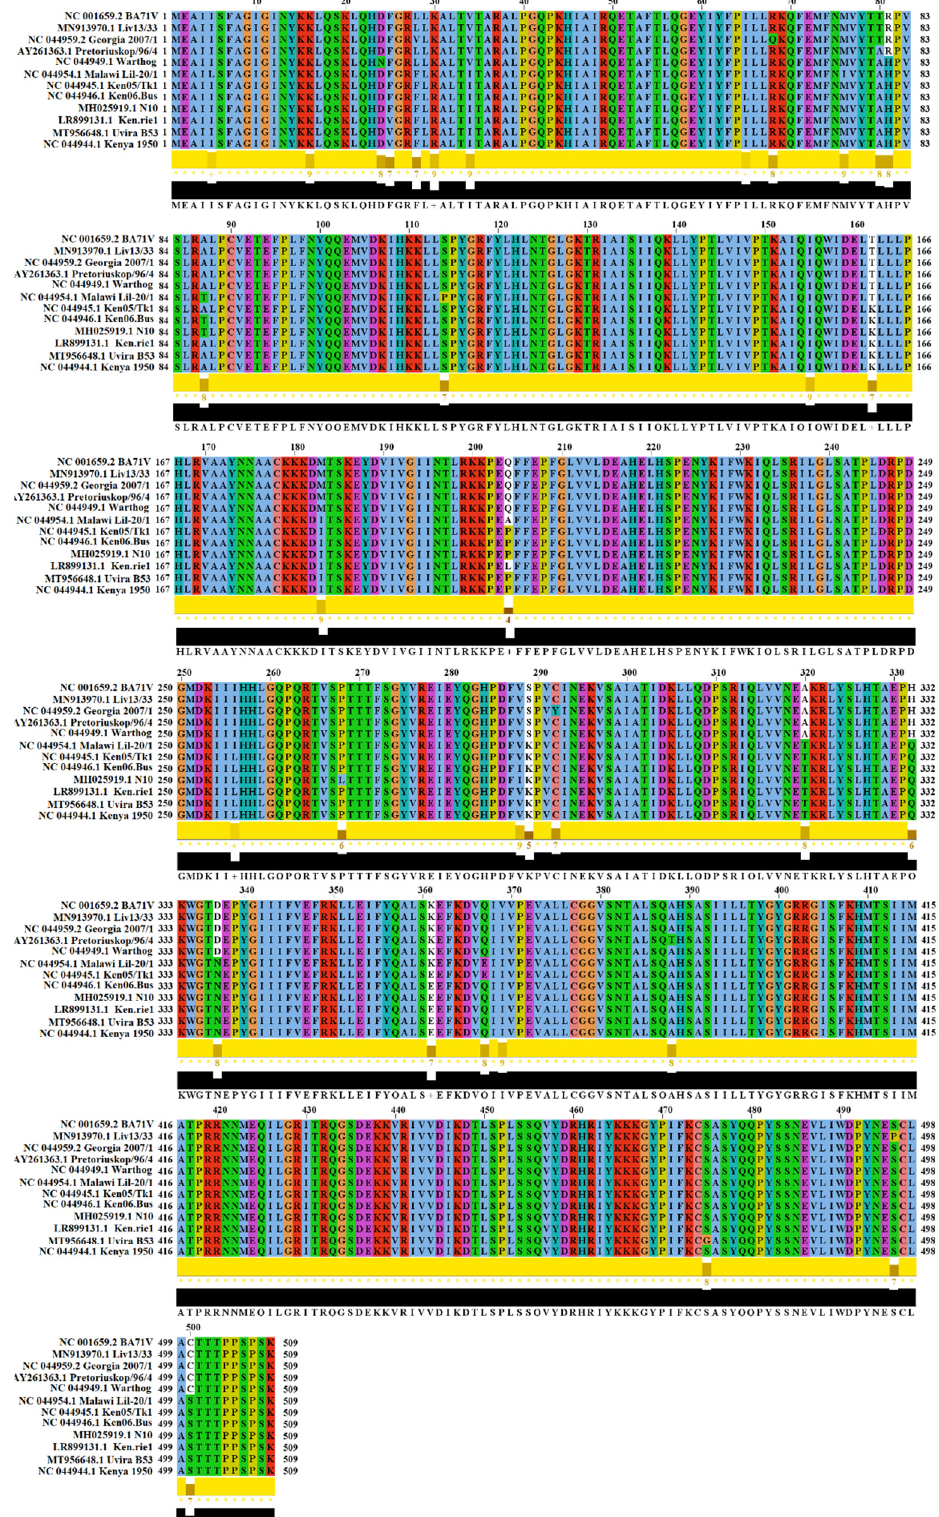
Figure 1. Evolution of QP509L protein among ASFV isolates. Amino acid alignment produced by the software Jalview version 2.11.1.7 showing the diversity of QP509L protein among a group of 12 representative ASFV isolates. Conservation plot scores reflect the nature of the change in specific sites. High scores are associated with changes with similar biological properties.